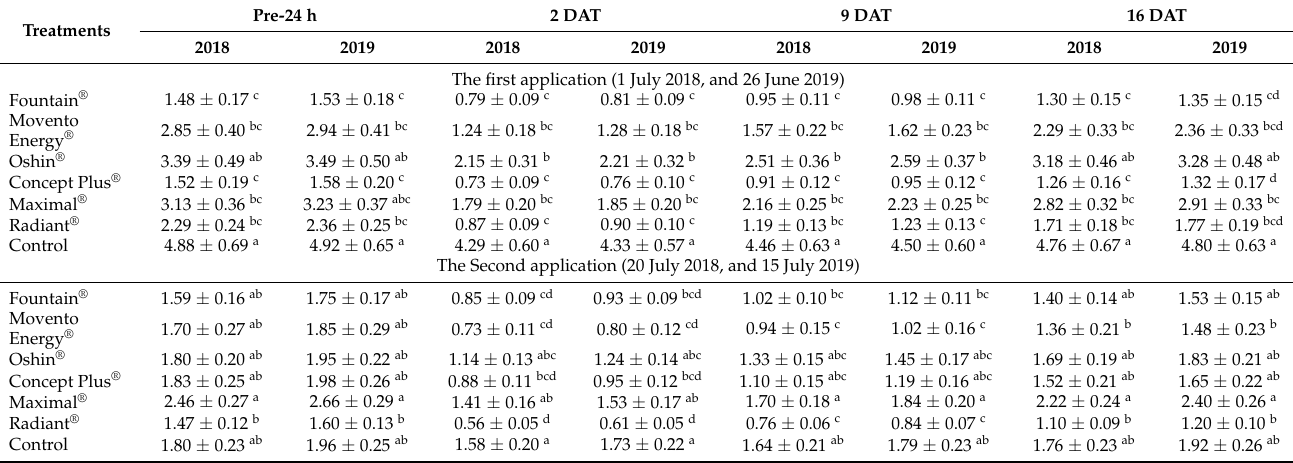
Table 3. Effect of selective insecticides on number (mean ± SEM) of adult jassids per leaf on cotton plants during 2018 and 2019. The data was recorded pre-24 h and 2, 9, and 16 days after treatment